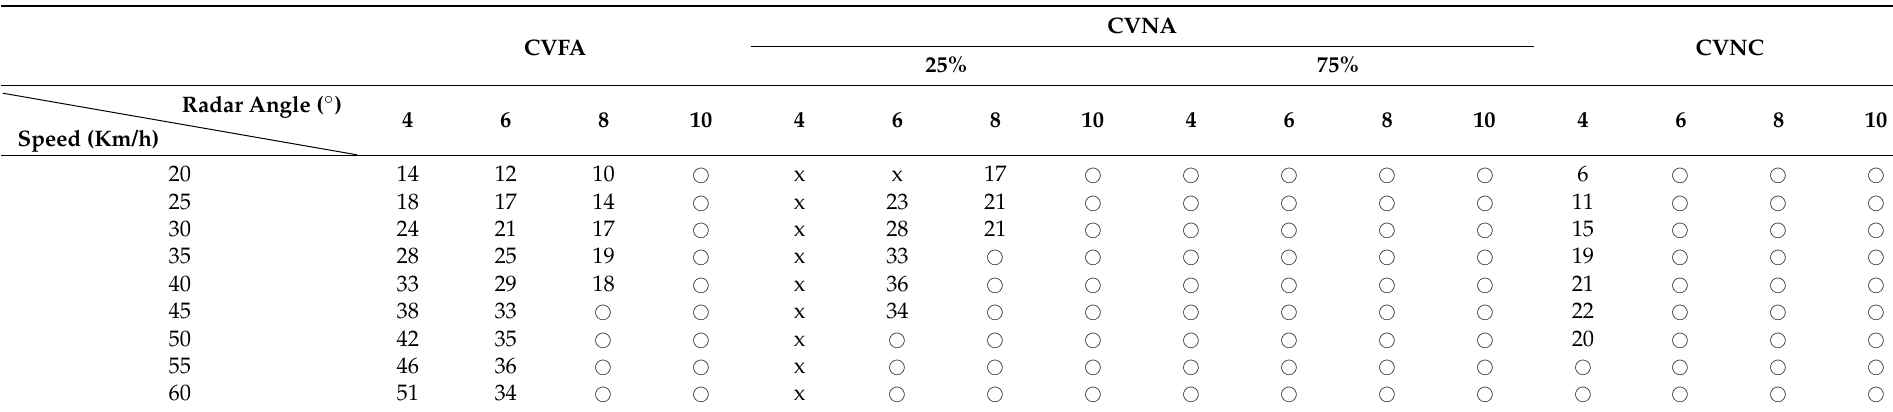
Table 4. AEBS scenario VRU-Pe